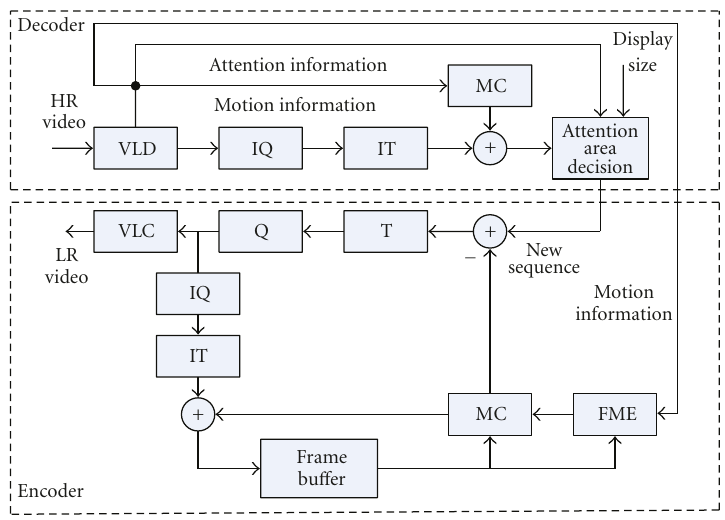
Figure 5: The structure of video adaptation